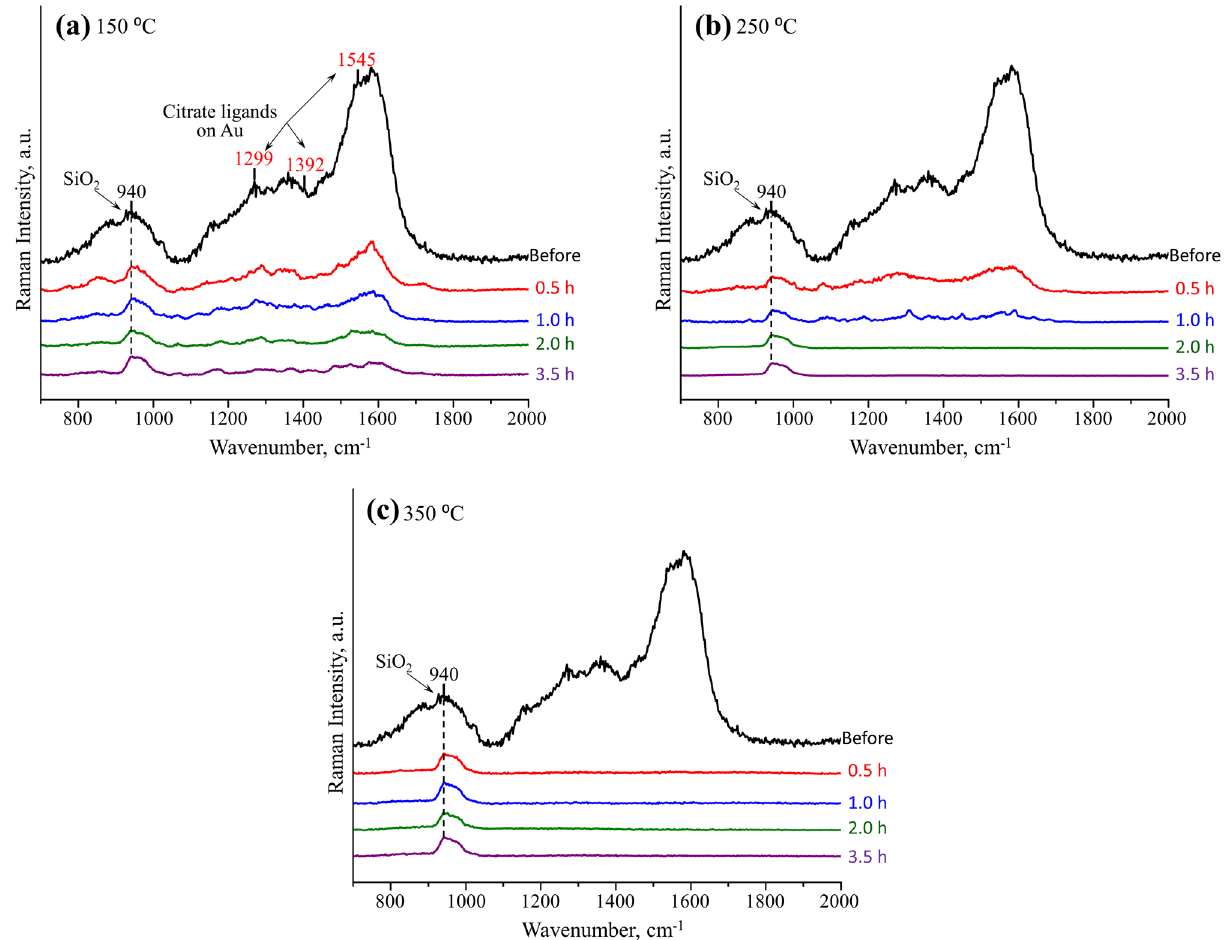
Figure 2. Raman spectra of 50 nm Au NPs supported on SiO 2 collected after thermal treatment at ( a ) 150, ( b ) 250 and ( c ) 350 °C for varying time period (0.5, 1, 2, 3.5 h) under N 2 atmosphere. Spectra were acquired at 632.8 nm (~ 8 mW, 20